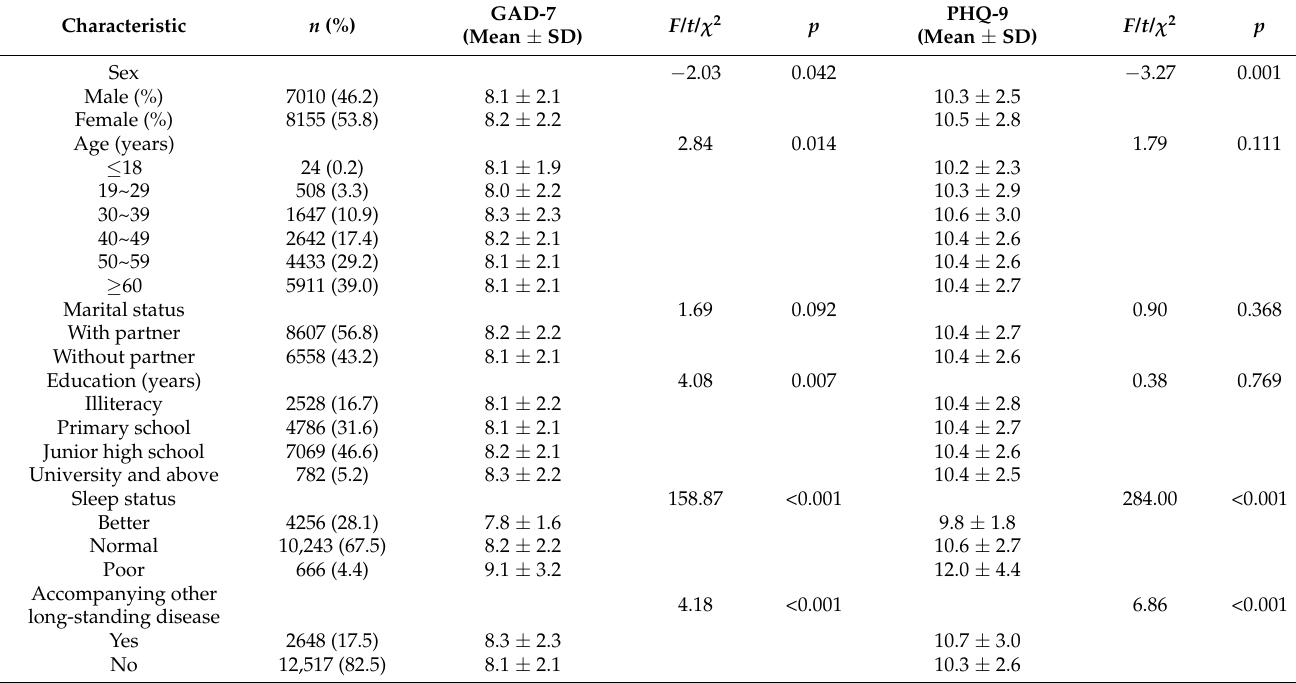
Table 2. Comparison of GAD-7 and PHQ-9 scores in patients with different characteristics.